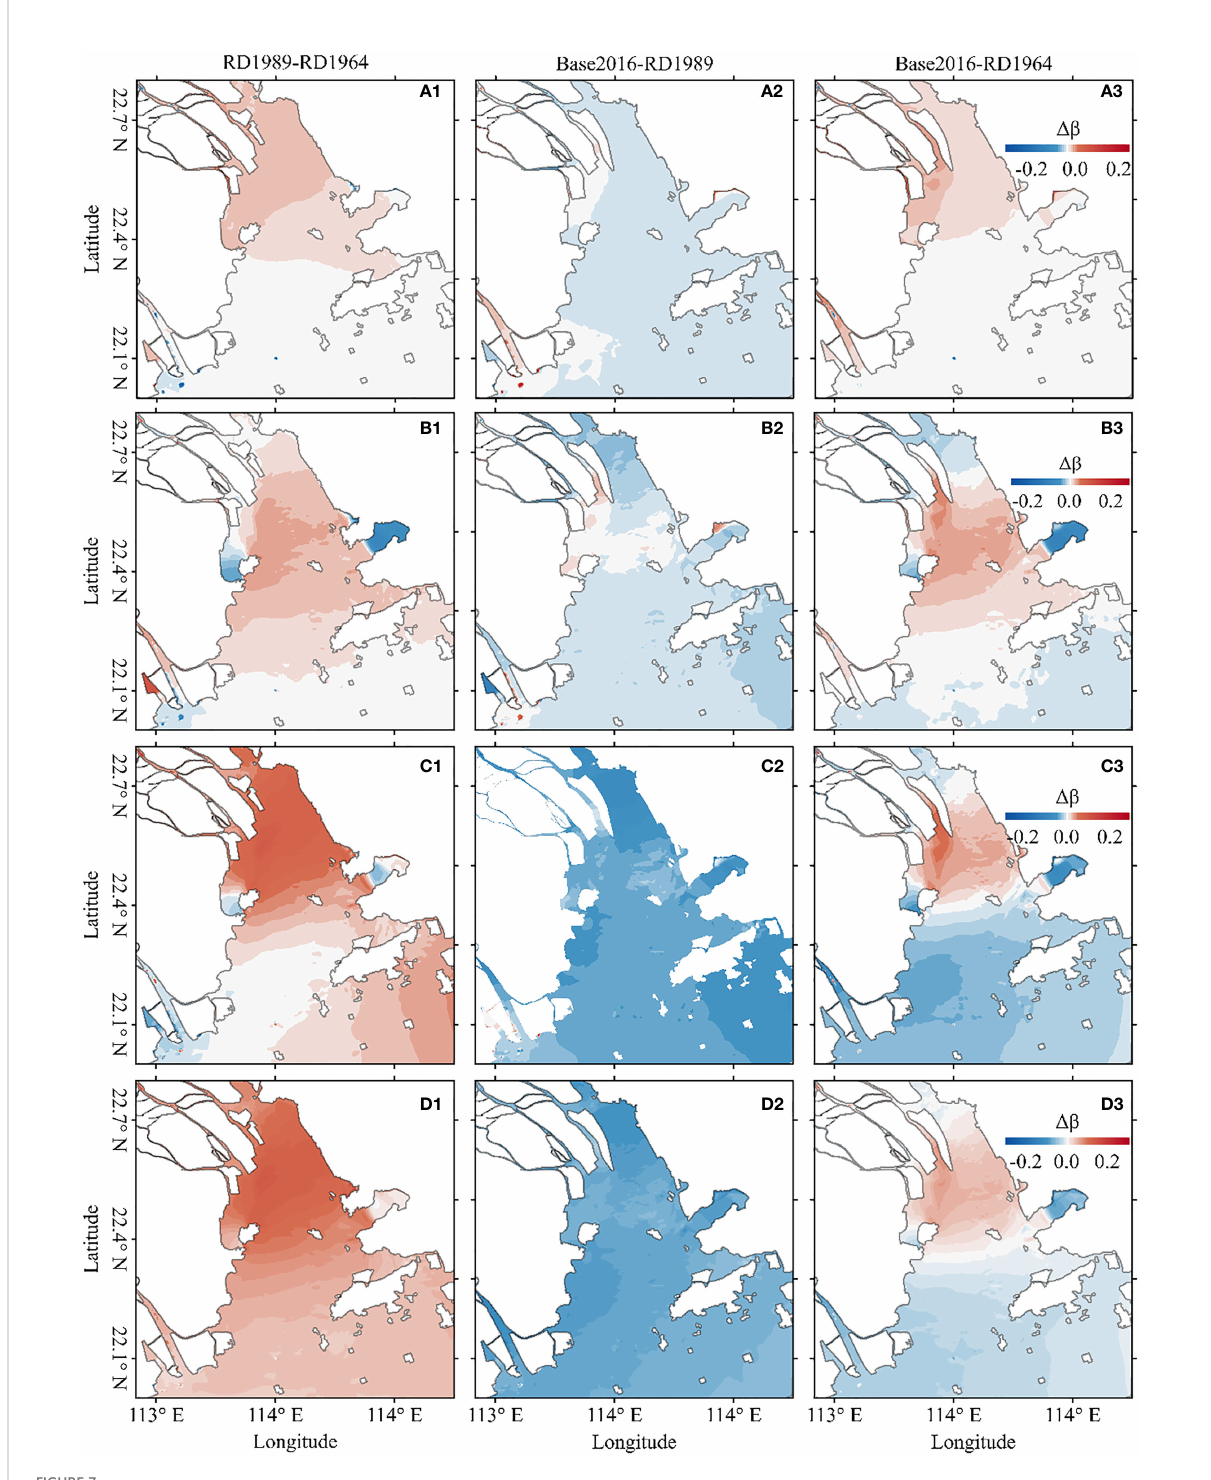
FIGURE 7 Contour map of the changes in primary contributors of tidal skewness, including b K 1/ O 1/ M 2 (A1 – A3) , b K 1/ M 2/ MK 3 (B1 – B3) , b M 2/ S 2/ MS 4 (C1 – C3) , and b M 2/ M 4 (D1 – D3) ; number 1, 2, 3 represent 1964-1989, 1989-2016, and 1964-2016,